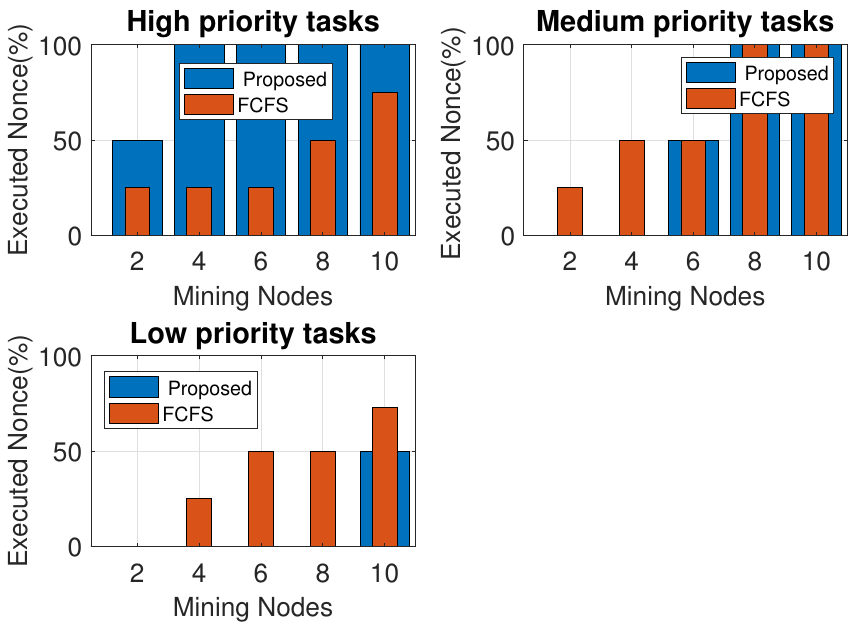
Figure 10. Percentage of the computed nonce for 12 data blocks with varying numbers of mining